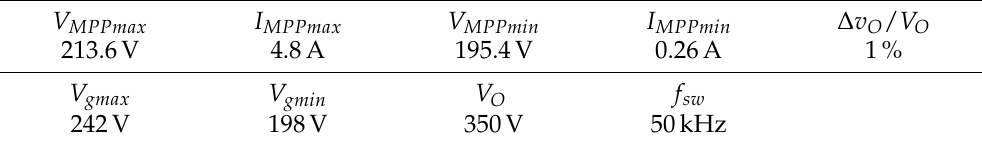
Table 2. Operating points of the 1 kW PV array designed for grid